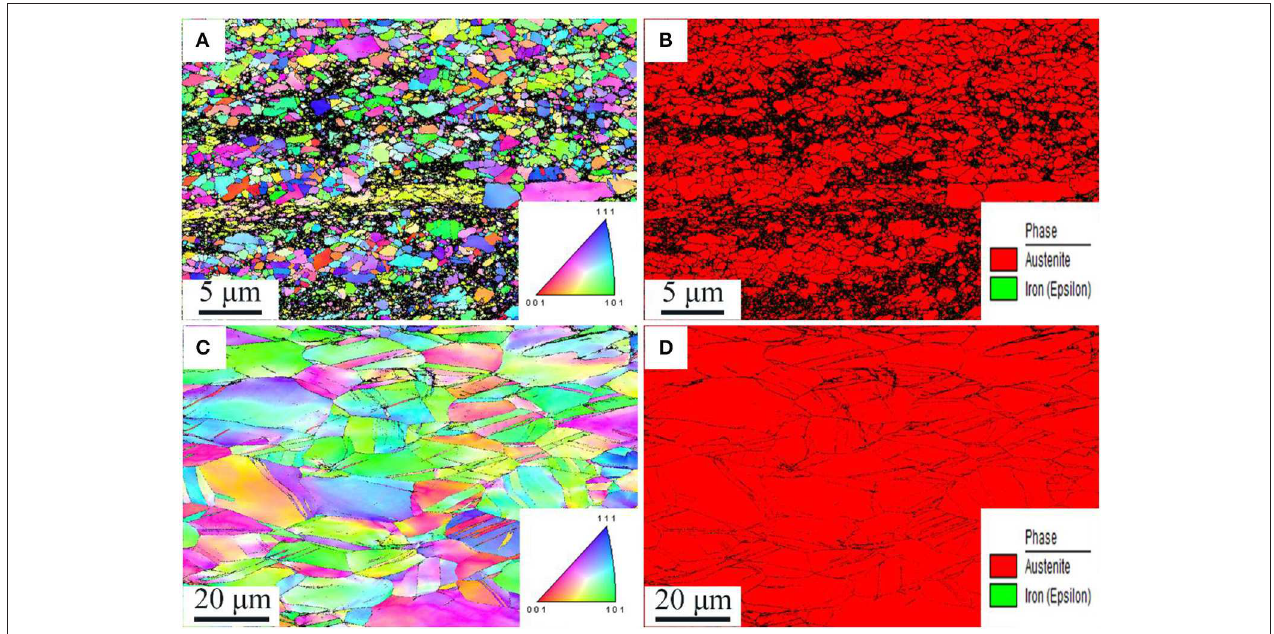
FIGURE 7 | EBSD images and phase images of samples with the grain sizes of 0.65 and 5.75 µ m after the tensile tested. (A) IPF and (B) phase images of the sample with the grain size of 0.65 µ m after the tensile test; (C) IPF and (D) phase images of the sample with the grain size of 5.75 µ m after the tensile test.